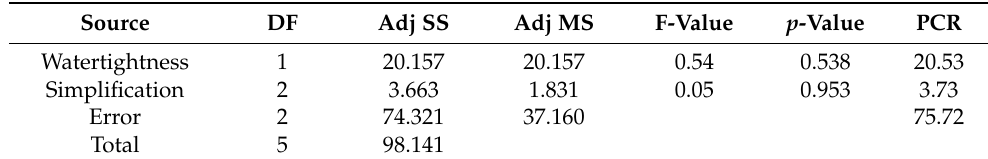
Figure 7. Main effects plot for volumetric error (mode D).